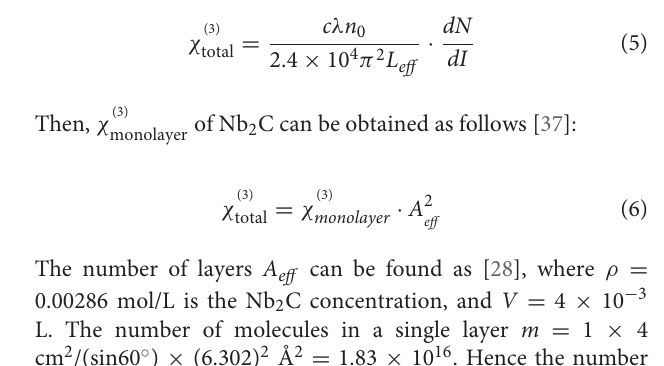
of rings N is determined by the formula 1Ψ (0)– 1Ψ ( ∞ ) = 2 N